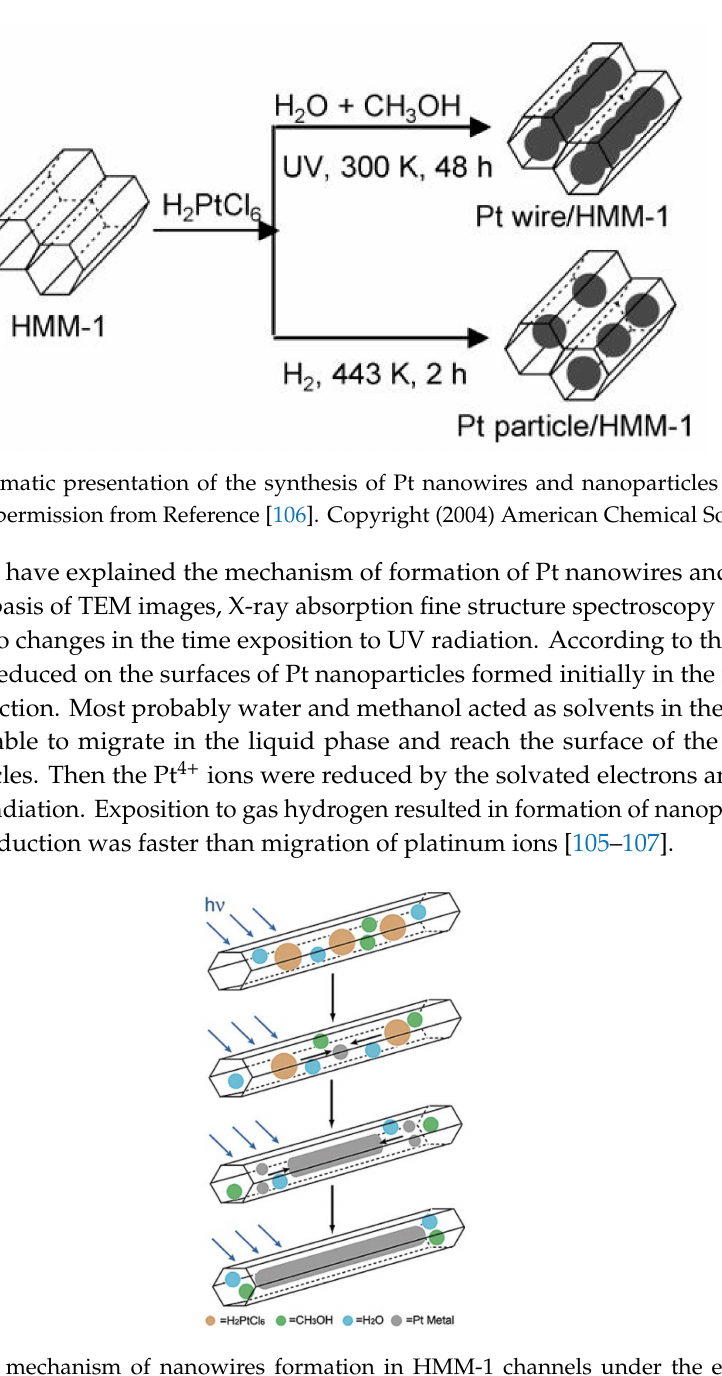
Figure 13. The mechanism of nanowires formation in HMM-1 channels under the e ff ect of UV irradiation, proposed by Fukuoka et al. Reprinted with permission from Reference [106]. Copyright (2004) American Chemical